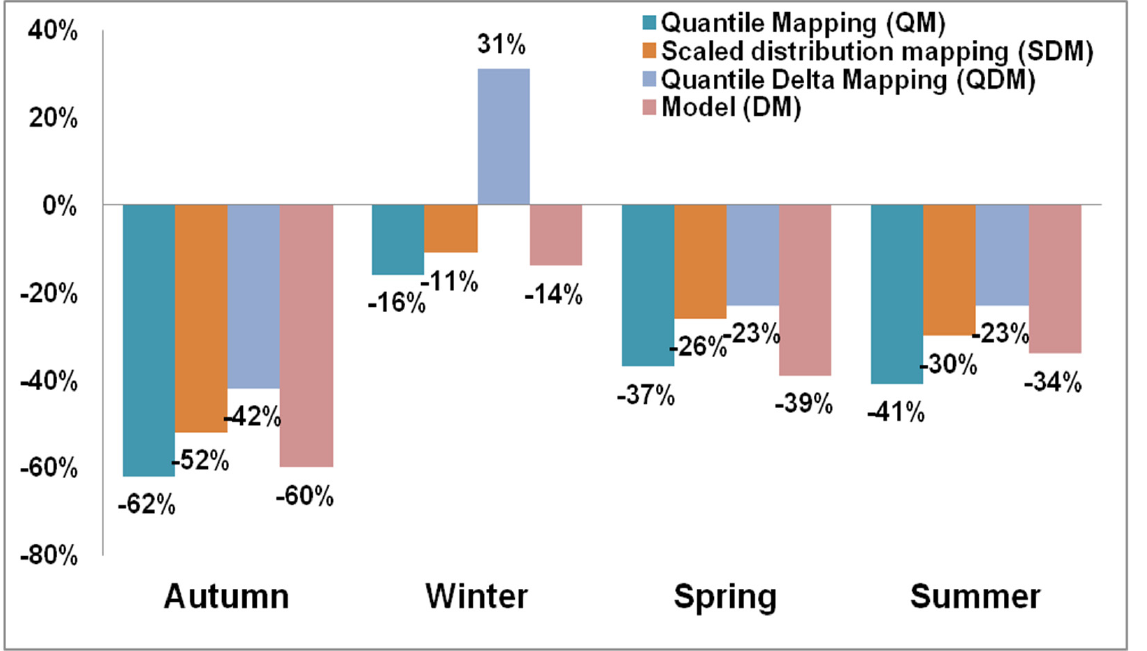
Figure 13. Seasonal streamflow mean variation over the CMT basins under the RCP4.5 and RCP8.5 climate scenarios.